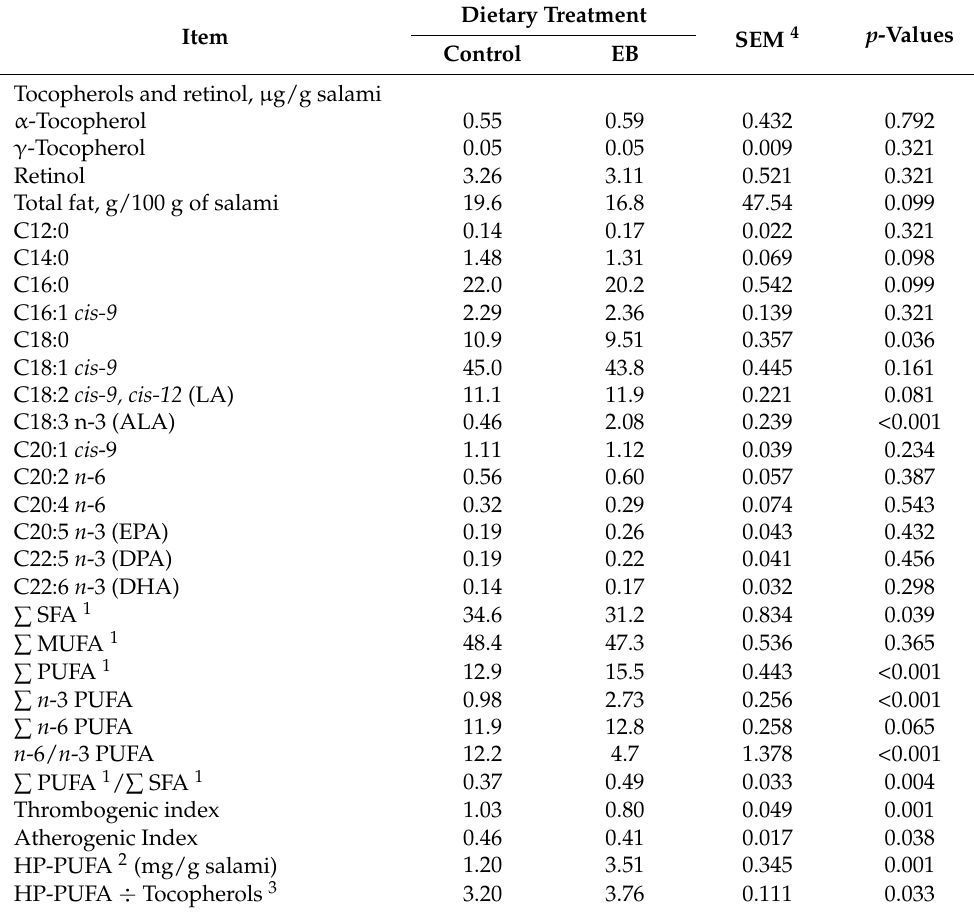
Table 6. Effect of exhausted bergamot by-product on the antioxidant vitamins and fatty acid profile of salami (g/100 g of total fatty